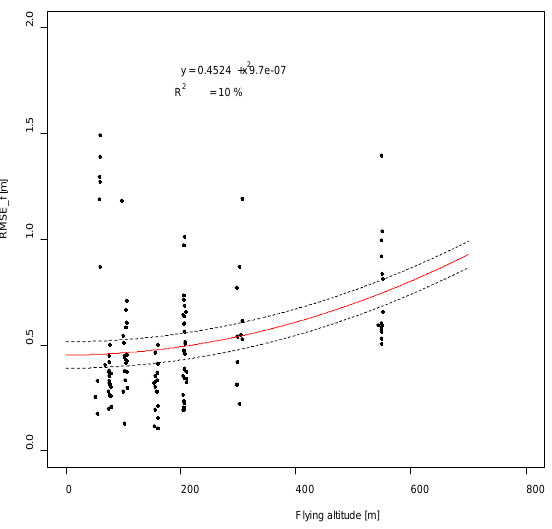
Figure 9. RMSE (determined with HI reference) in relation to the flight